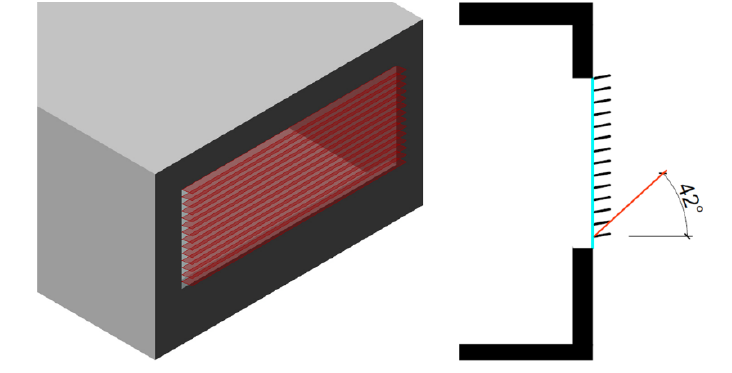
Figure 6. Best case